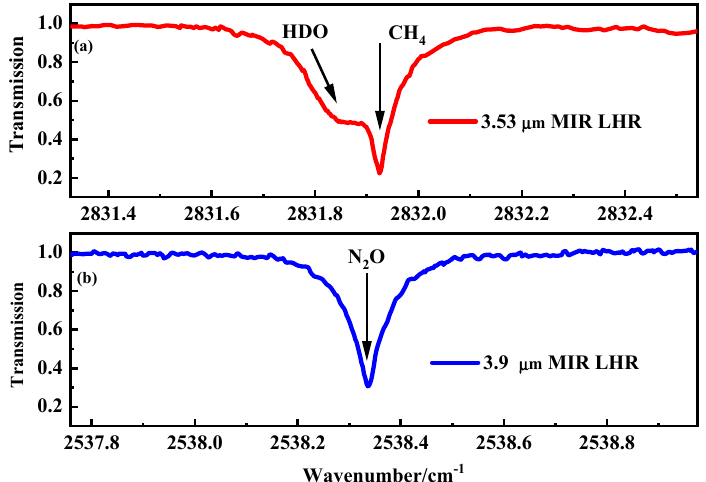
Figure 3. Atmospheric transmittance spectra measured by MIR LHR. ( a ) CH 4 at 2831.92 cm − 1 ; ( b ) N 2 O at 2538.34 cm − 1 .